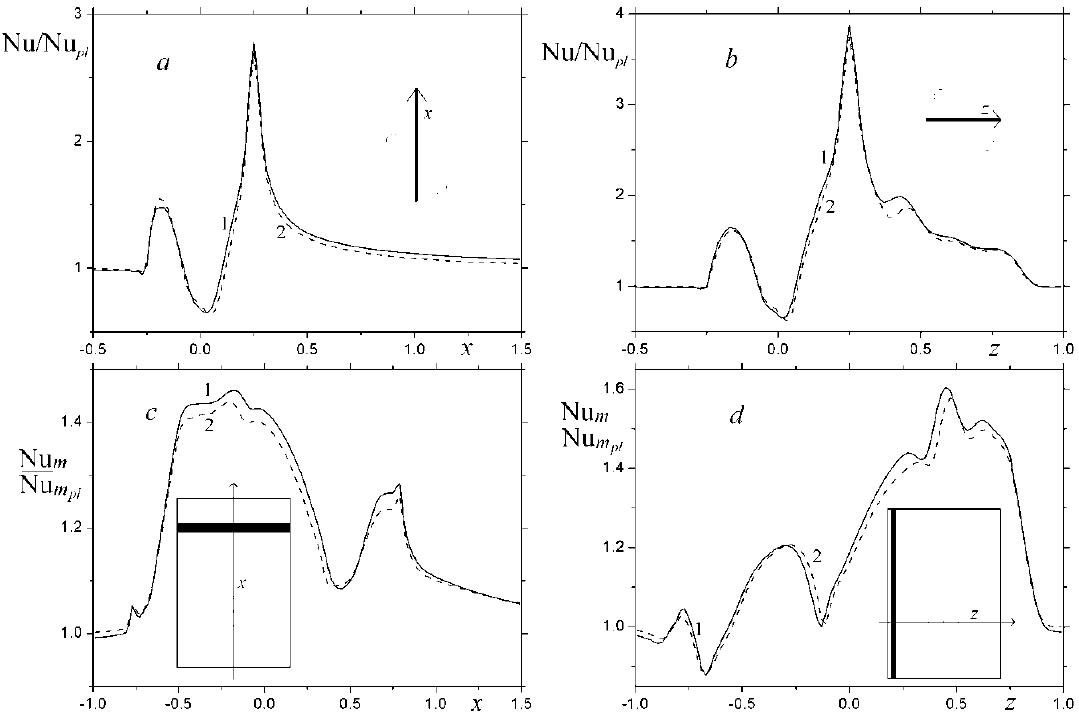
Figure 10. Distributions of relative local Nusselt numbers ( a , b ) and Nusselt numbers averaged over transverse ( c ) and longitudinal ( d ) strips of the rectangular section with the oval dimple ( c , d ) in longitudinal ( a,c ) and lateral ( b , d ) directions calculated on different grids: 1—initial variant (about 1.6 mln cells); 2—refinement (about 3 mln cells). Table 4. VP2/3 code validation of the predictions of extreme flow, heat transfer and turbulence parameters for the narrow channel with the oval dimple of width b = 0.383.